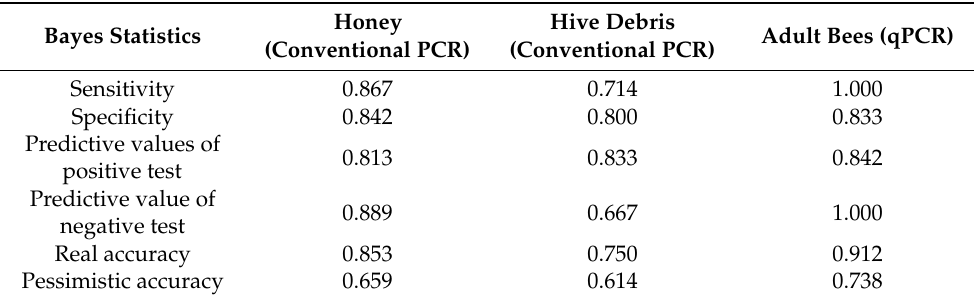
Table 3. Comparative statistical parameters in a model population with 52% prevalence of the M. plutonius in honey, hive debris and adult bees.